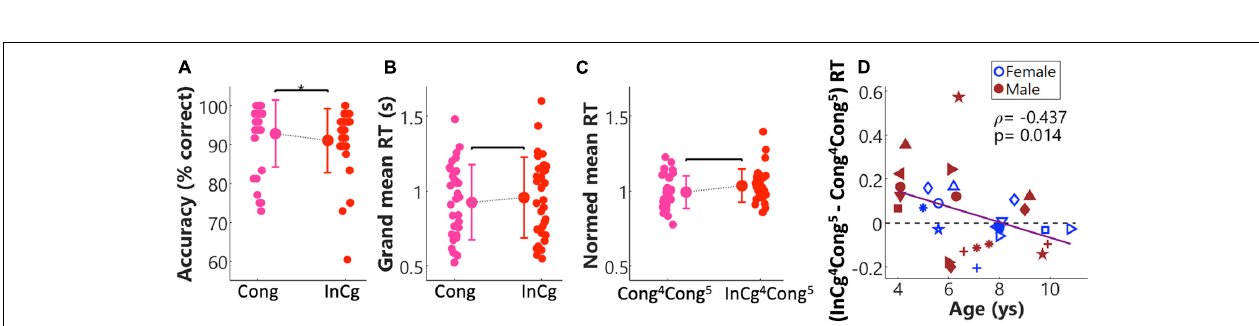
FIGURE 5 | Correlations between behavioral measures in the fNIRS session and standardized assessments in the NIH Toolbox cognition battery. Panels (A–C) plot the Spearman correlations between d-prime values and uncorrected scores from the Dimensional change card sort, Flanker inhibitory, and List sorting working memory, respectively. Panels (D–F) plot the Spearman correlations for the standard error of mean (SEM) of reaction times (RT)s. The same symbols and colors (blue for females and red for males) were used for individuals as in Figure 1 .